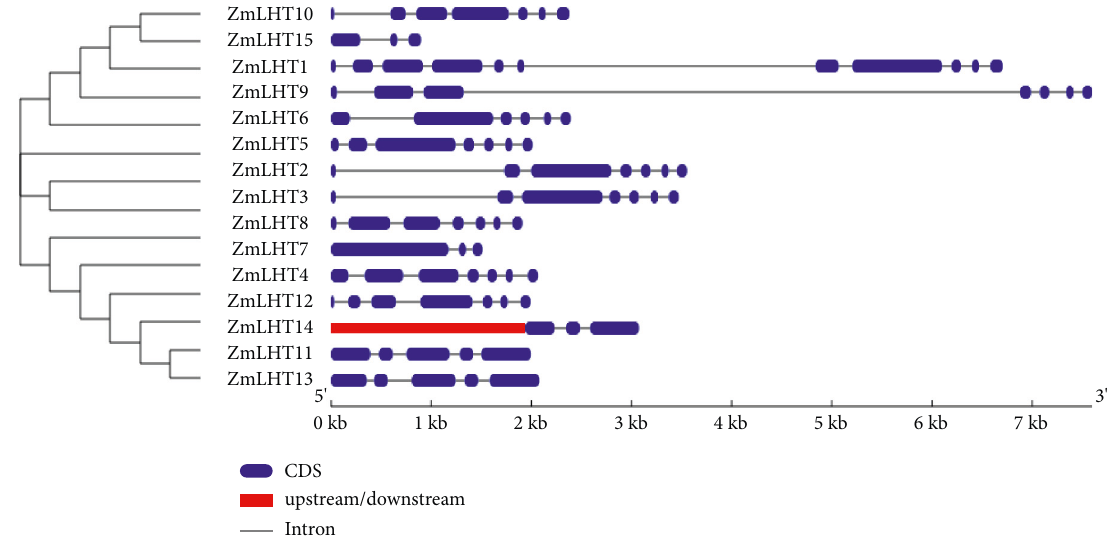
Figure 2: Analysis of exon-intron structure of LHT gene family in maize.